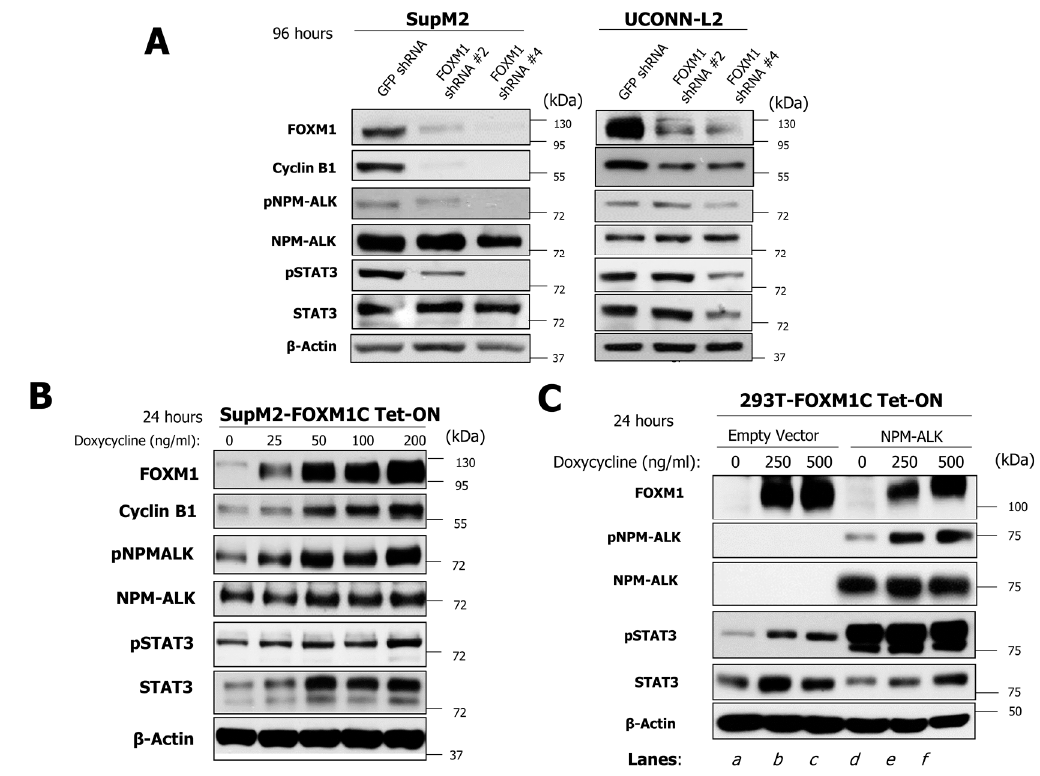
Figure 5. FOXM1 positively regulates the NPM-ALK / STAT3 signaling axis. ( A ) Western blot analysis of the indicated proteins in SupM2 and UCONN-L2 cells treated with two individual FOXM1 shRNA for 96 h. ( B ) Expression of the indicated proteins in SupM2 cells following exposure to increasing concentrations of doxycycline for 24 h, which activates expression of FOXM1. β -actin was used as a loading control. ( C ) Western blot analysis for expression of proteins in cells over-expressing FOXM1 in a dox-inducible manner in 293T cells transiently transfected to express NPM-ALK. Western blot data are representative of at least two biological replicates for each cell